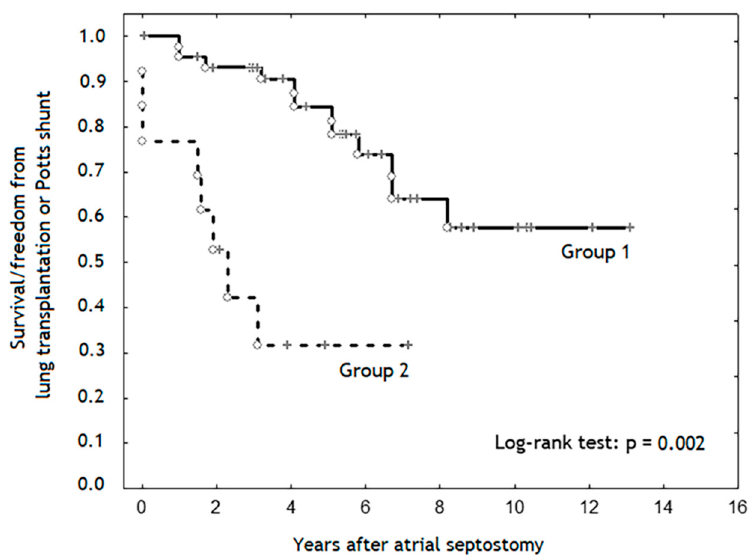
Figure 1. Kaplan–Meier survival curve. Patients from the “intermediate” risk group (Group 1) demonstrate significantly higher survival rate than patients from the “high” risk group (Group 2) ( p = 0.015).